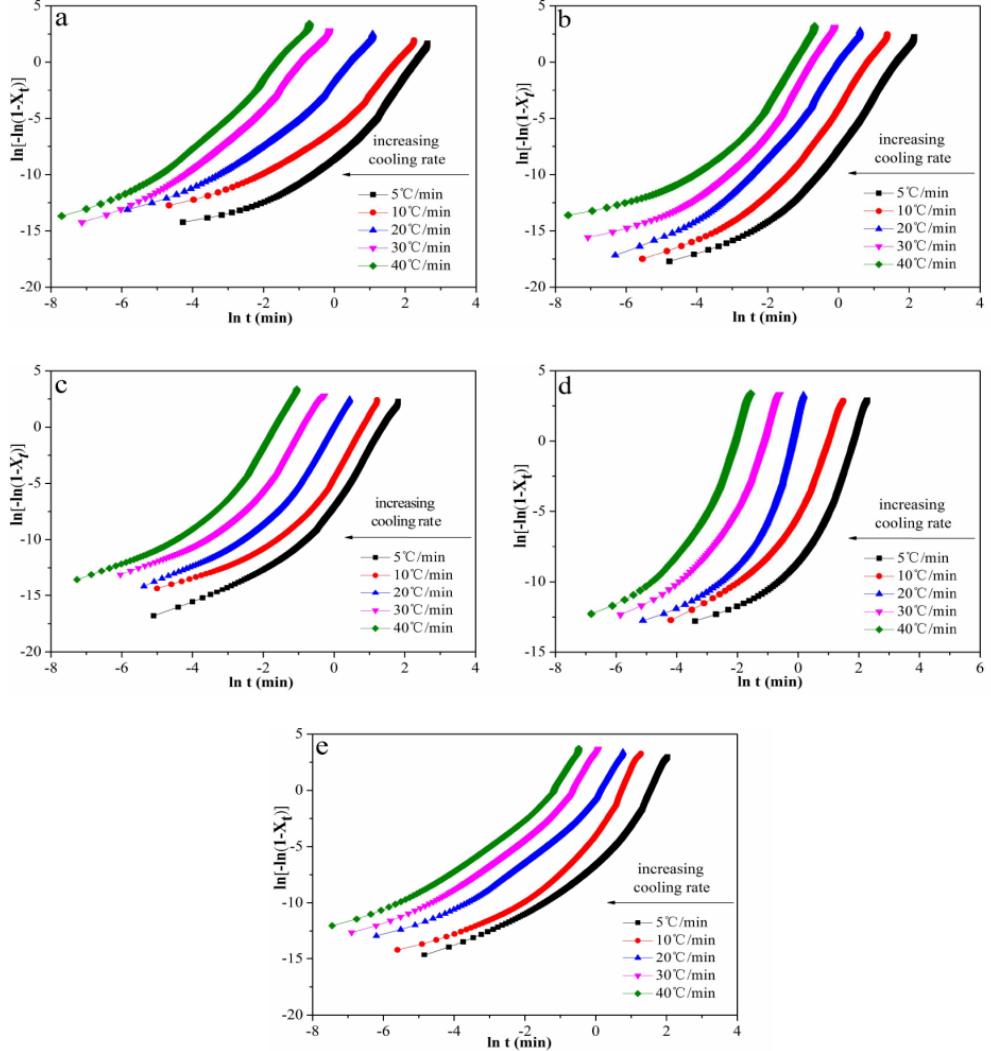
Figure 9. Plots of ln( − ln(1 − X t )) as a function of ln( t ) for POM/Ag nanocomposites with different Ag nanoparticle contents: ( a ) 0, ( b ) 0.1, ( c ) 0.5, ( d ) 1, ( e ) 2 wt % at the cooling rates of 5, 10, 20, 30 and 40 °C/min.